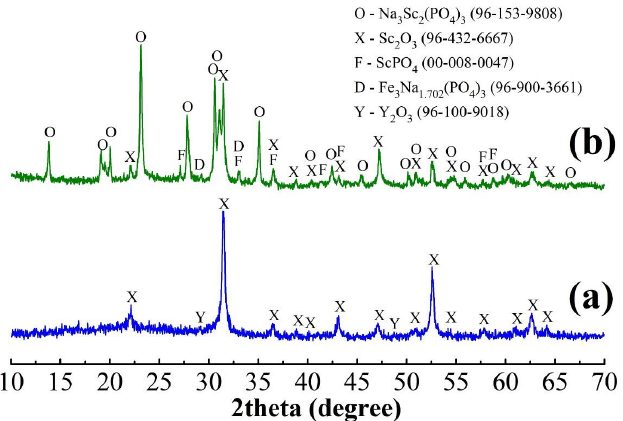
Figure 11. The XRD patterns of scandium concentrate obtained from exps. 2 ( a ) and 3 ( b ). In exp. 3, difficult-to-separate Sc 2 (C 2 O 4 ) 3 was formed by stripping using the mixture of ammonium oxalate and oxalic acid. Despite the insolubility of Sc 2 (C 2 O 4 ) 3 in water, scan- dium was precipitated incompletely. Probably, a soluble complex of (NH 4 )Sc(C 2 O 4 ) 2 was formed in the presence of an excess of oxalate ions, namely, the stable anion Sc(C 2 O 4 ) 2 − [61]. The addition of a two-phase system of precipitate-forming fluoride ions of lower concentration compared to exp. 2 led to the appearance of a white suspension immiscible with neither organic nor aqueous phases. This suspension was separated by centrifuga- tion, and then it was analyzed after calcination at 1000 °C by XRD. As can be seen from the XRD pattern (Figure 11), the calcined precipitate consists of a mixture of scandium oxide and phosphate, as well as thermally stable scandium-sodium double phosphate Na 3 Sc 2 (PO 4 ) 3 . Accordingly, the created conditions led to the formation of a stable and in- soluble compound in these media, which indicates a strong affinity of scandium for